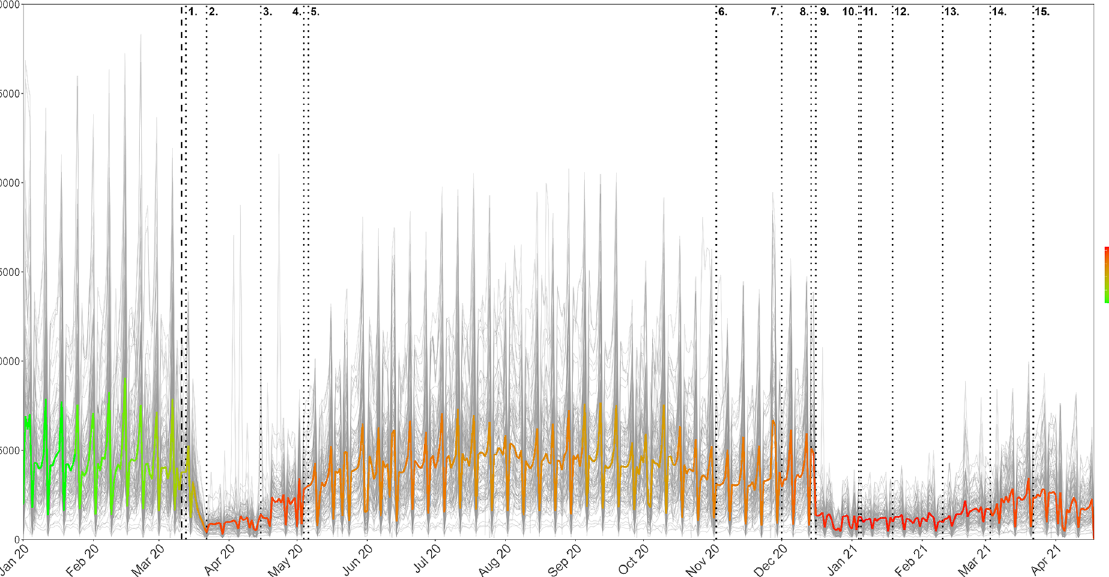
Grey lines show recordings of each sensor. The gradient-colour line shows a) the average daily count, and b) indicates the stringency index (green = low index score, red = high index score).The vertical black dashed line indicates the WHO declaration. The enumerated vertical black dotted lines indicate a point in time with a policy intervention (enumeration corresponds to Table